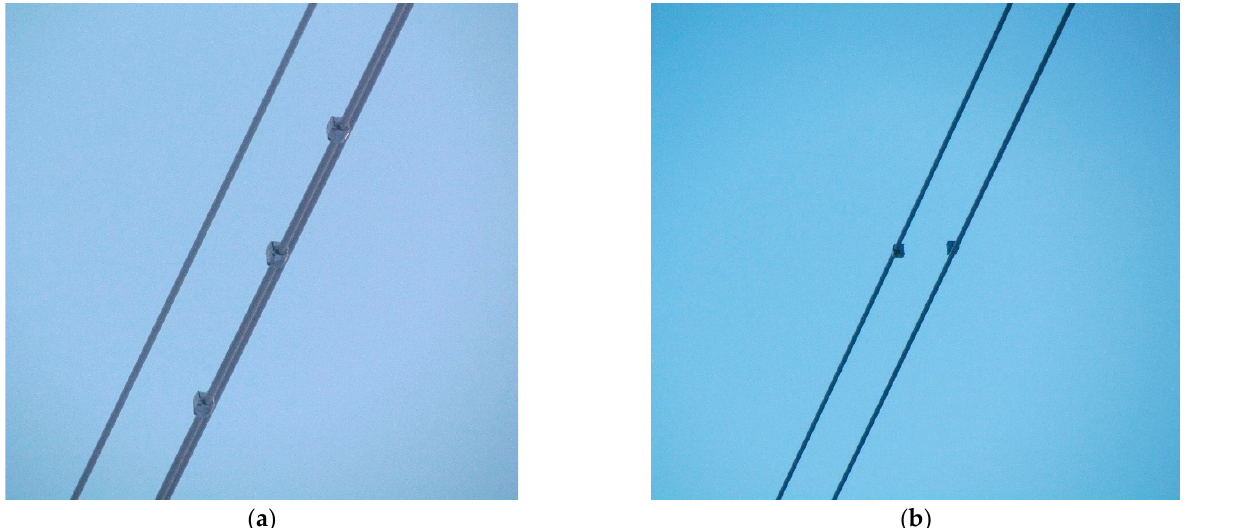
Figure 15. Sensor nodes positioning inside the span: ( a ) configuration for the detection of aeolian vibrations and galloping; ( b ) configuration to detect subspan